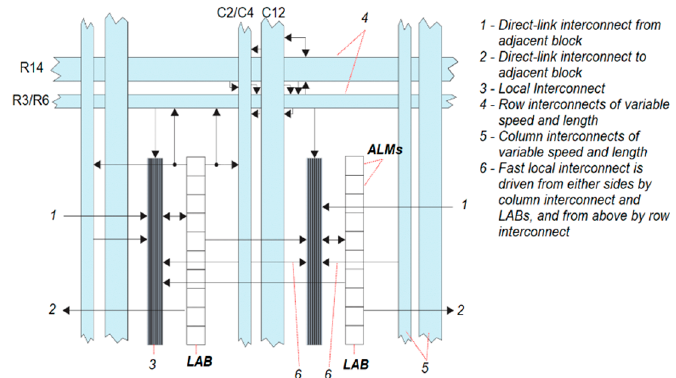
Figure 5. Cyclone V routing architecture.